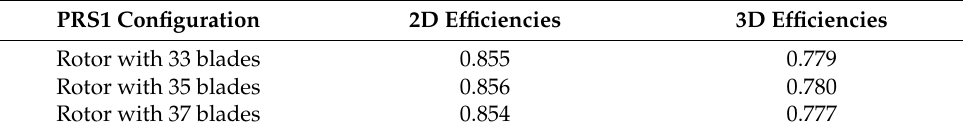
Table 2. Efficiencies computed by solving different configuration of PRS1.